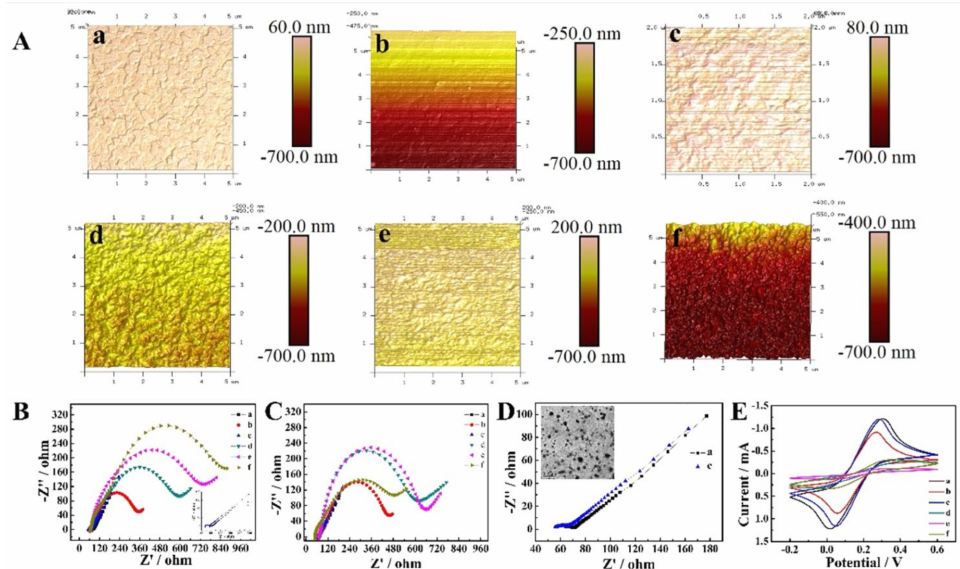
Figure 1. ( A ) Three-dimensional AFM images and ( B ) EIS curves of ( a ) bare ITO, ( b ) APTMS/ITO, ( c ) AuNPs/Ti 3 C 2 -MXenes/APTMS/ITO, ( d ) after to catch cTnI aptamer, ( e ) final cTnI sensor, and ( f ) responded to cTnI, the inset in ( B ) shows the enlarged EIS curves ( a ) and ( c ); ( C , D ) EIS curves and ( E ) CV curves of [Fe(CN) 6 ] 3 − /4 − on (a) bare ITO, ( b ) APTMS/ITO, ( c ) AuNPs/Ti 3 C 2 - MXenes/APTMS/ITO, ( d ) after to catch Myo aptamer, ( e ) final Myo sensor, and ( f ) responded to Myo, the inset in ( D ) is the TEM image of AuNPs/Ti 3 C 2